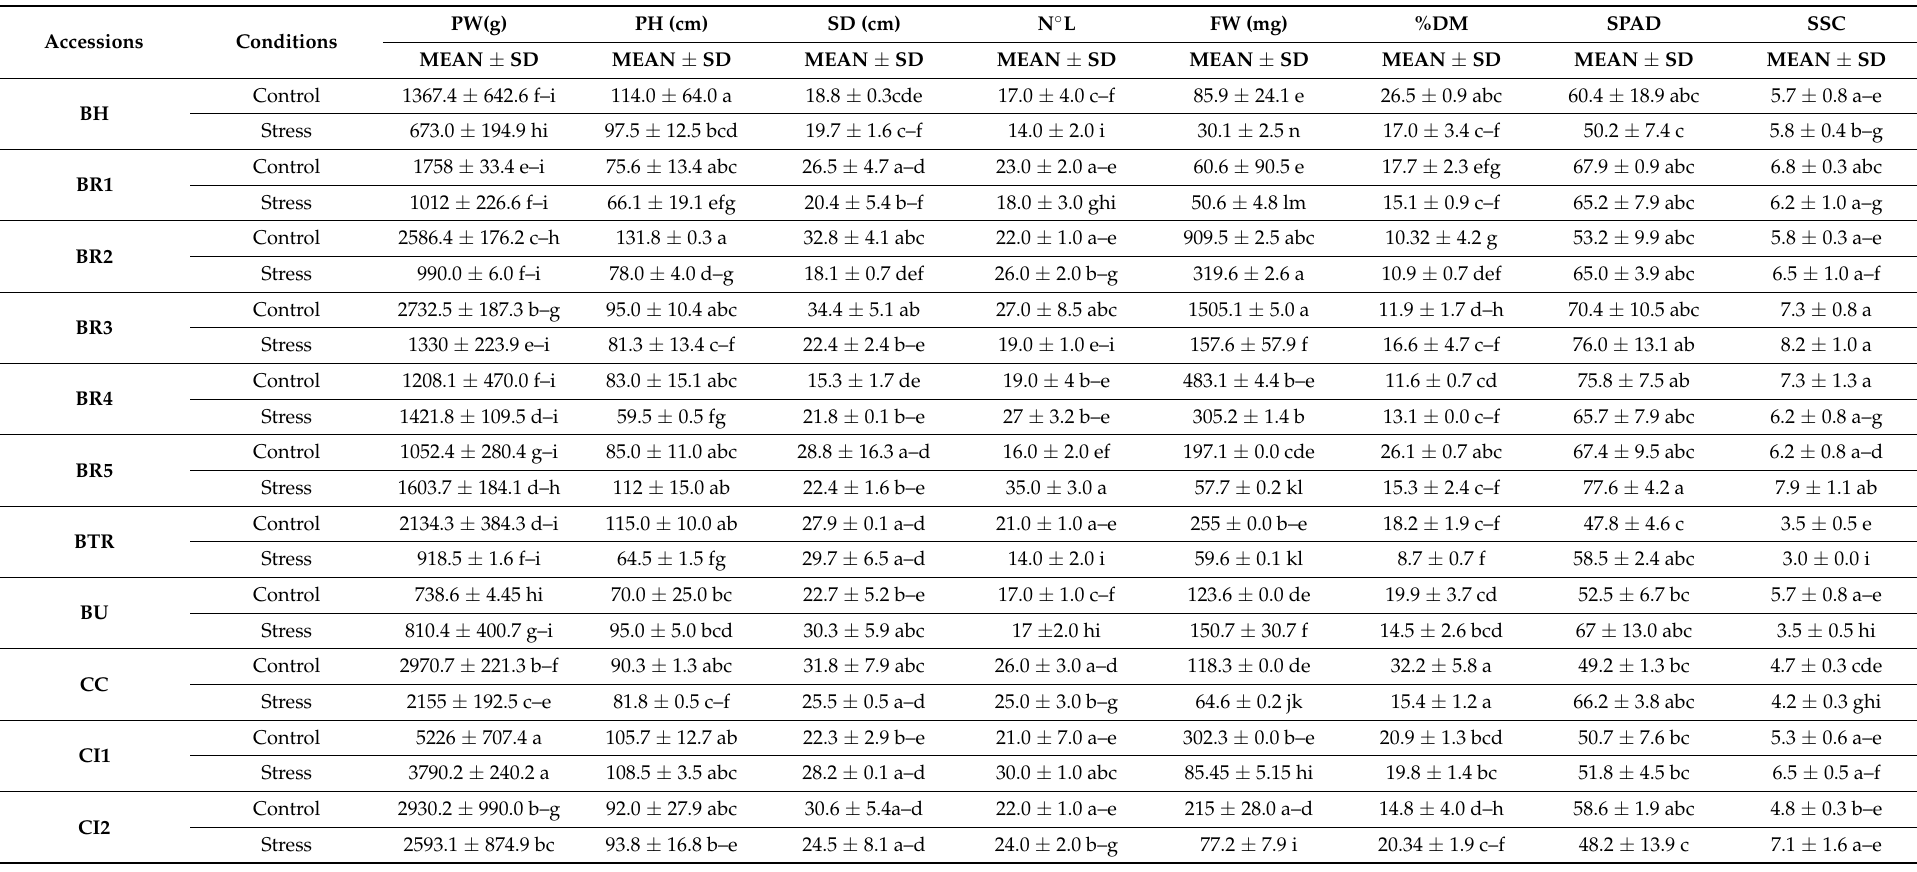
Table 1. Variation of morphological traits (Mean ± SD) studied in the 20 accessions of Brassica oleracea